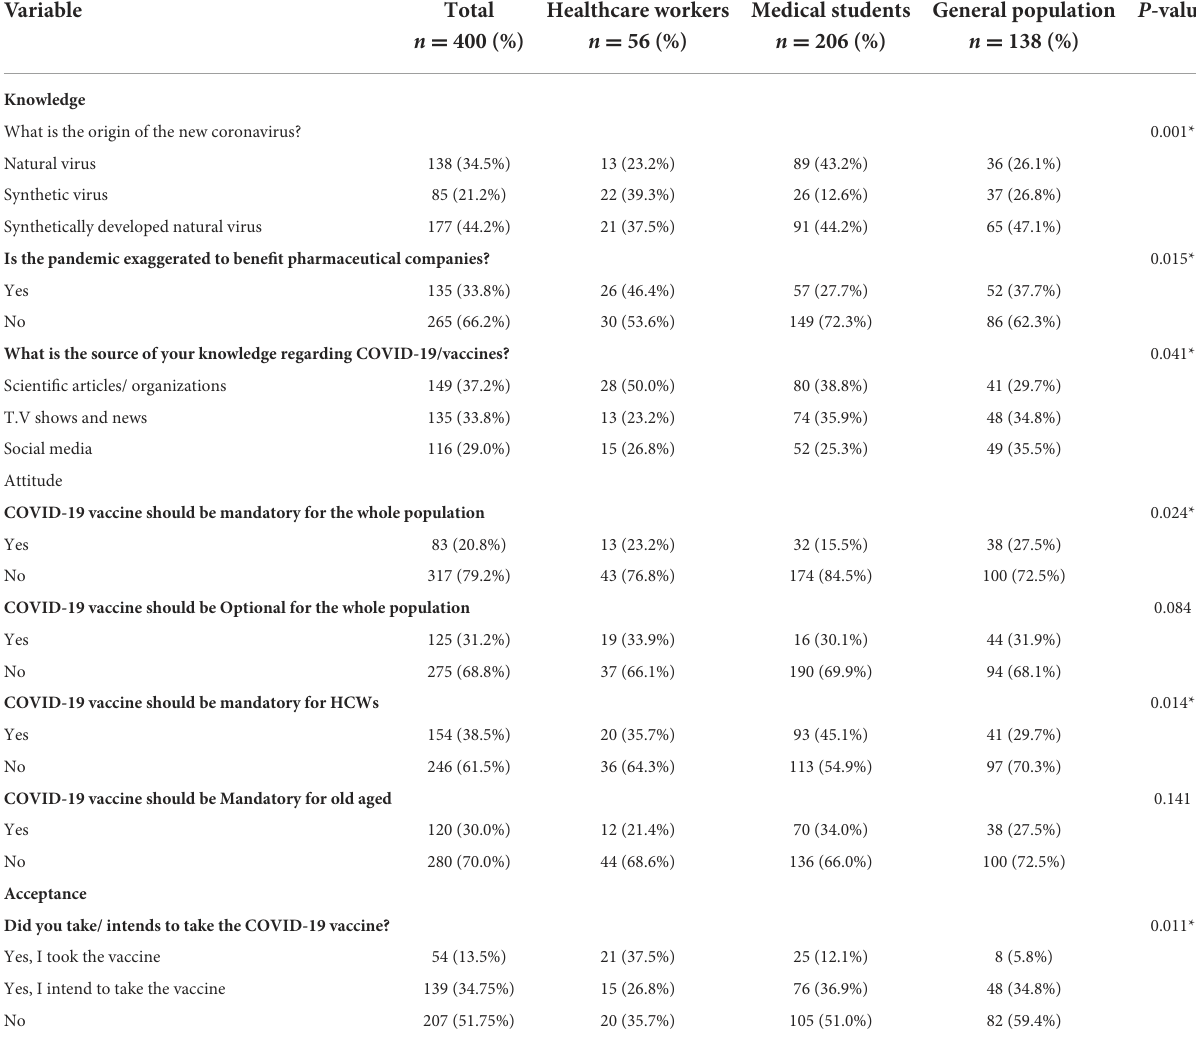
TABLE 3 Knowledge, attitude, and acceptance regarding COVID-19 and COVID-19 vaccines by